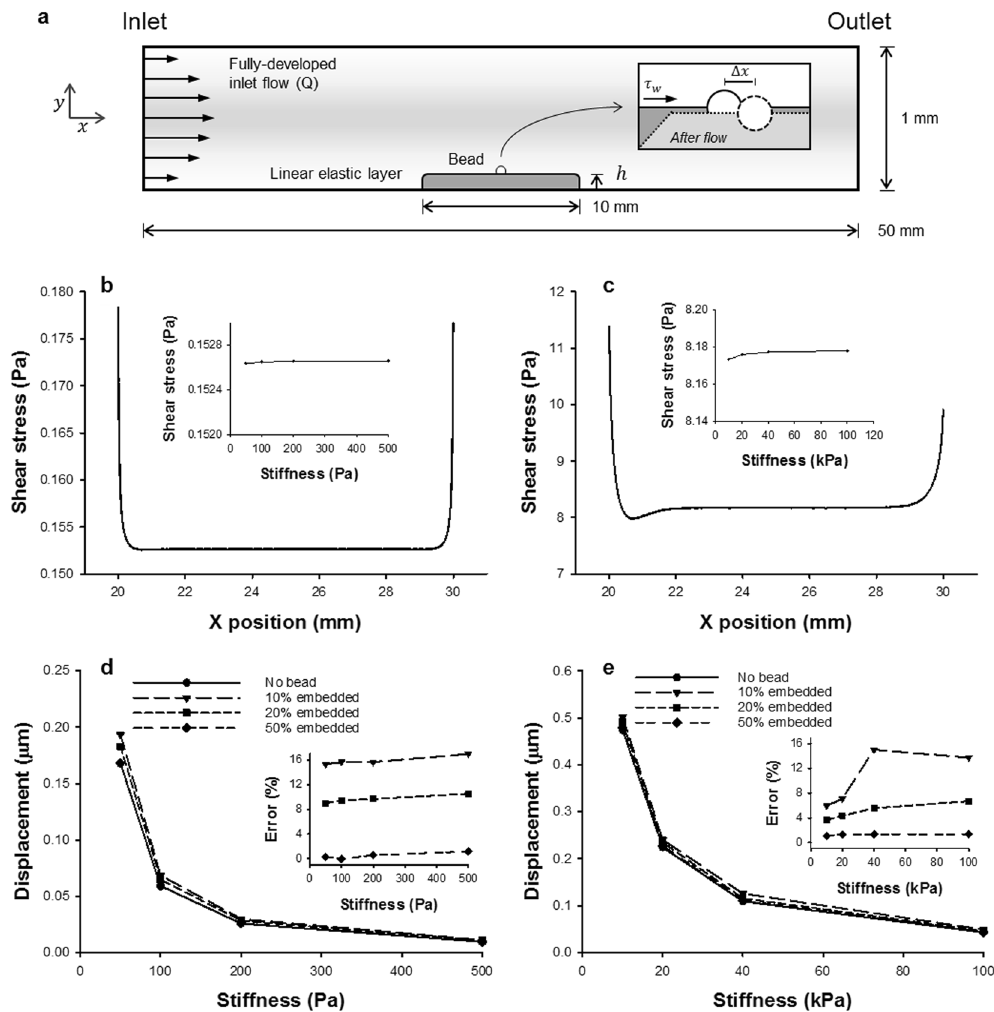
Figure 1. Numerical simulations of wall shear stress ( τ w ) and displacement ( Δ x ) for a linearly elastic layer representing a cell or tissue layer. A schematic of the 2D flow chamber simulations is shown in ( a ). Here, a linearly elastic solid was attached to the bottom of the chamber and exposed to a fully-developed flow at the inlet position. A rigid bead (diameter of 1 or 4 μ m for cell or tissue, respectively) was attached at the midpoint of the elastic layer and embedded to 10, 20, or 50% of its diameter. Panels (b) and (d) correspond to simulations for a cell layer with Young’s moduli ranging between 50 and 500 Pa, whereas panels (c) and (e) correspond to simulations for a tissue layer with higher stiffness ranging between 10 and 100 kPa. In both cases, τ w (panels b and c) was observed to be independent of stiffness and relatively constant across the length of the elastic solid (with the exception of expected increases at the boundaries). The insets demonstrate virtually no change in τ w at the midpoint of the solid as a function of the stiffness. Furthermore, Δ x (panels d and e) at the midpoint of the elastic solid was shown to decrease with increases in stiffness for both the cell and tissue simulations, as would be expected. The insets demonstrate that although the error in Δ x using the center of the bead compared to no bead can reach ~16% when the bead is only marginally embedded (e.g., 10%), the error quickly approaches zero as the embedding